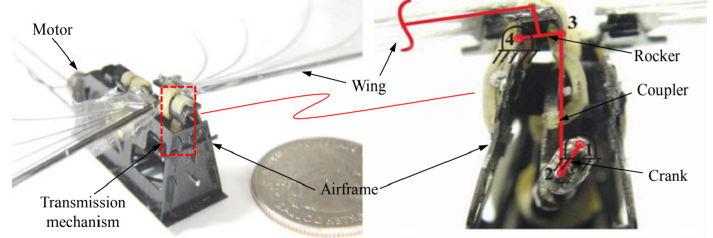
Figure 2. The prototype of the Harvard University’s FWMAV and its four-bar transmission mechanism.